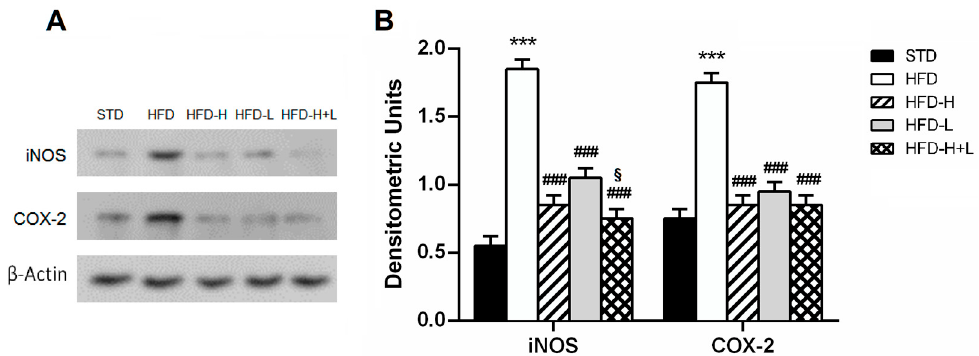
Figure 5. Brain stress. ( A ) protein expression levels of COX-2 and iNOS in the mouse brain of different groups; ( B ) densitometric analysis of iNOS and COX-2 protein levels normalized for β -actin levels. Data are mean values ± S.E.M. (n = 8/group). *** p < 0.001 vs. STD mice; ### p < 0.001 vs. HFD mice; § p < 0.05 vs. HFD-L mice.